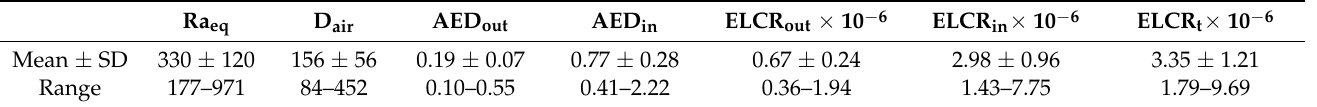
Table 7. The associated environmental hazard variables in the